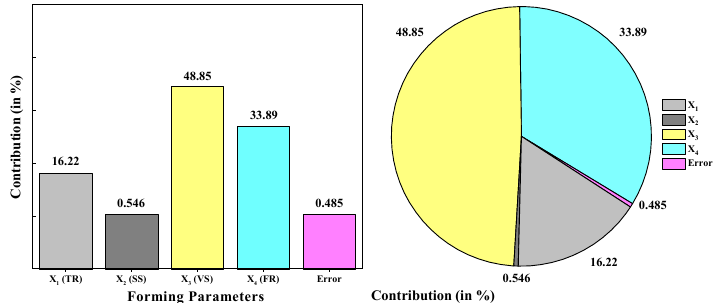
Figure 6. Contribution of forming parameters on measured surface roughness based on ANOVA